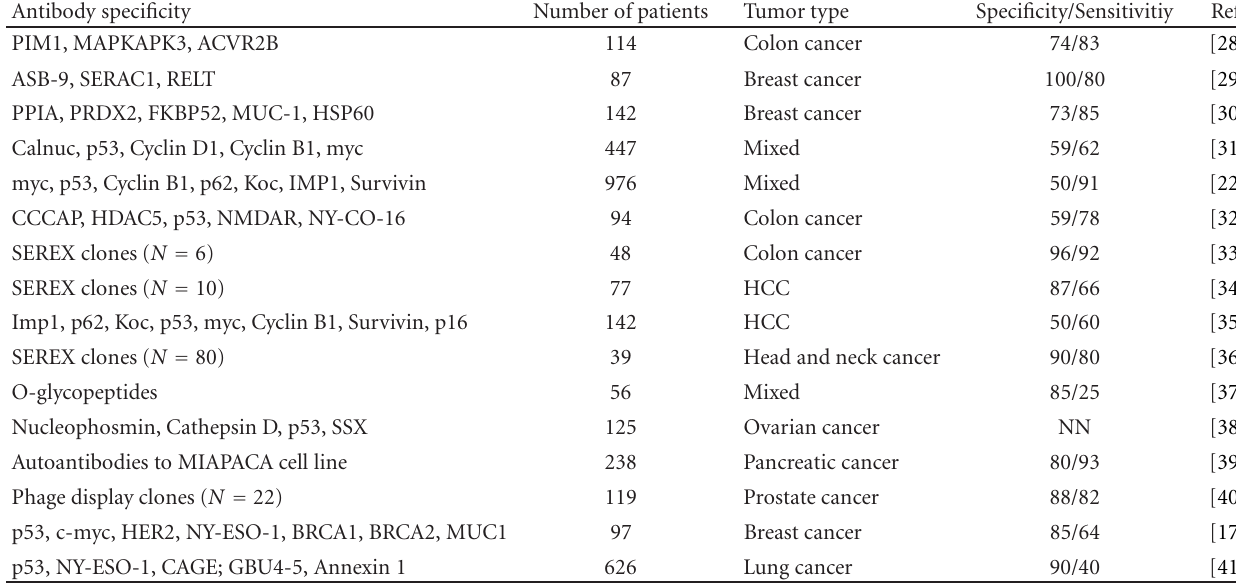
Table 1: Combinations of autoantibodies evaluated as diagnostic